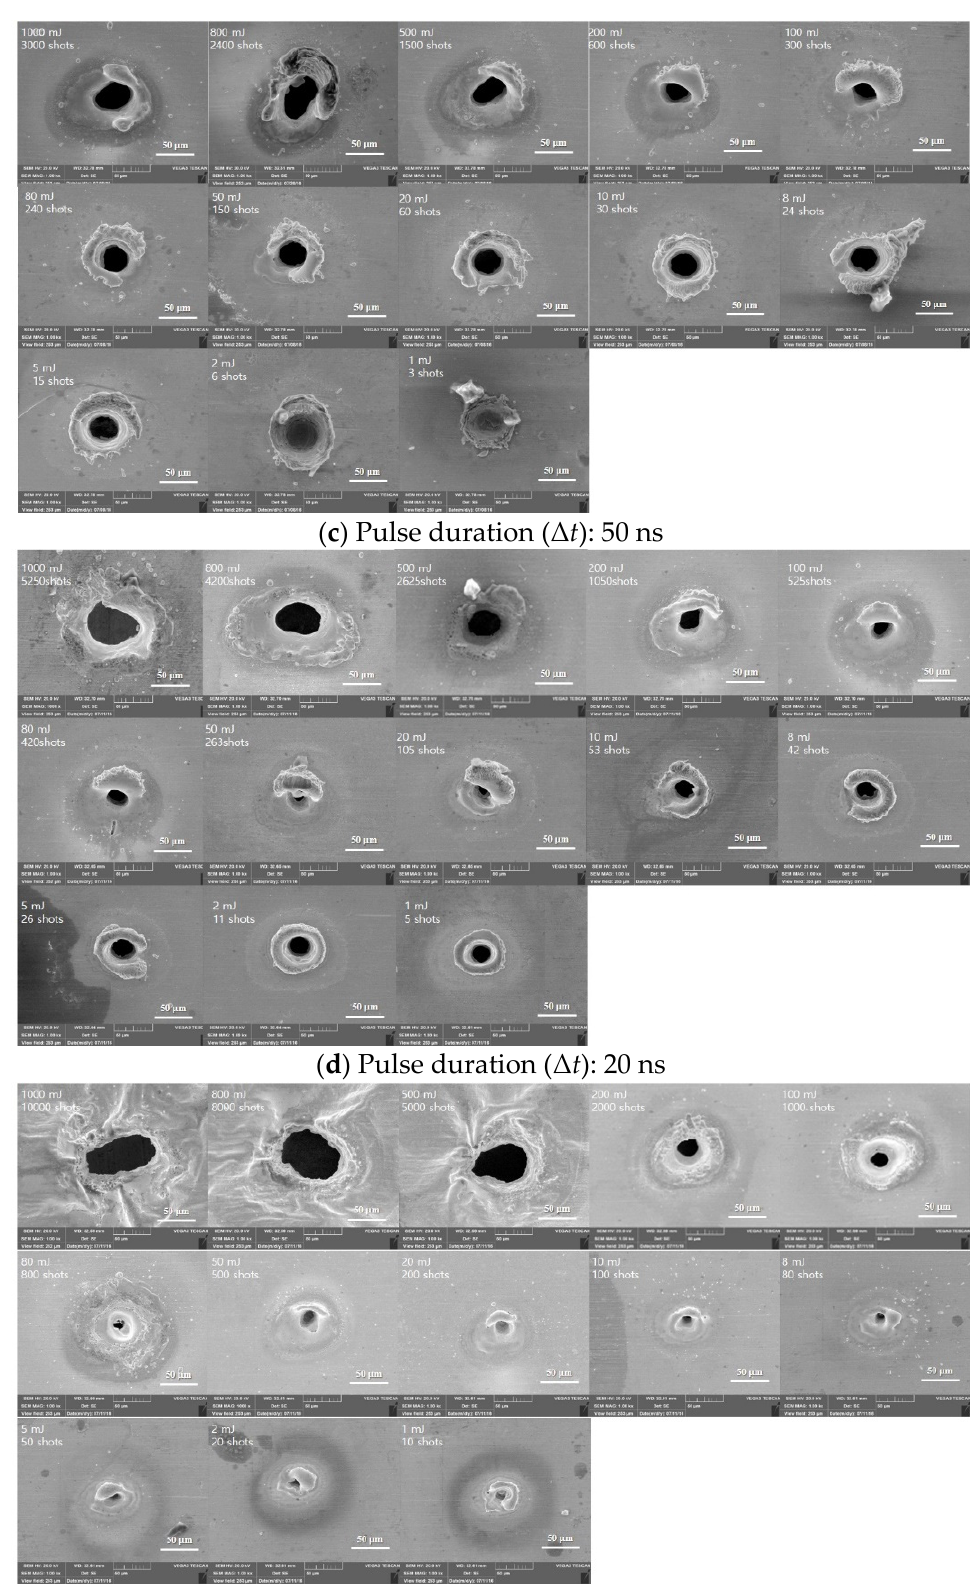
Figure 10. Top view of laser ablation on Au-coated surface with different pulse duration .